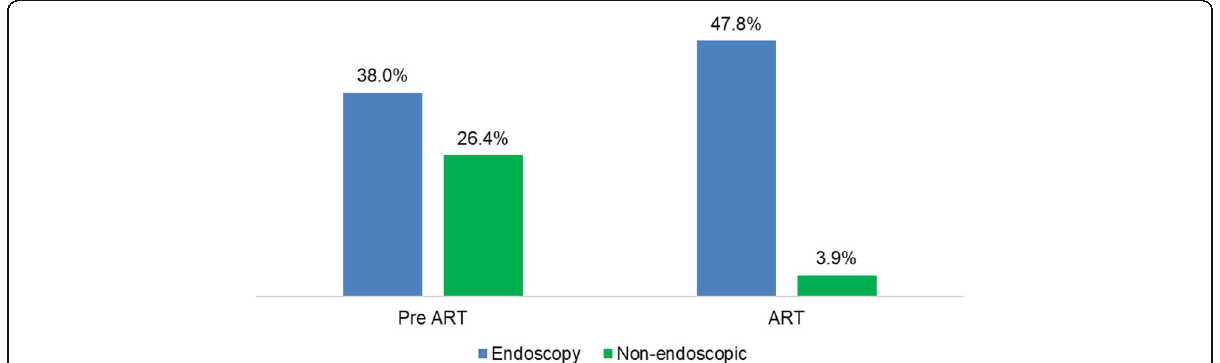
Fig. 7 Mean prevalence of HIV-associated esophageal candidiasis in the pre-ART and ART era by diagnostic